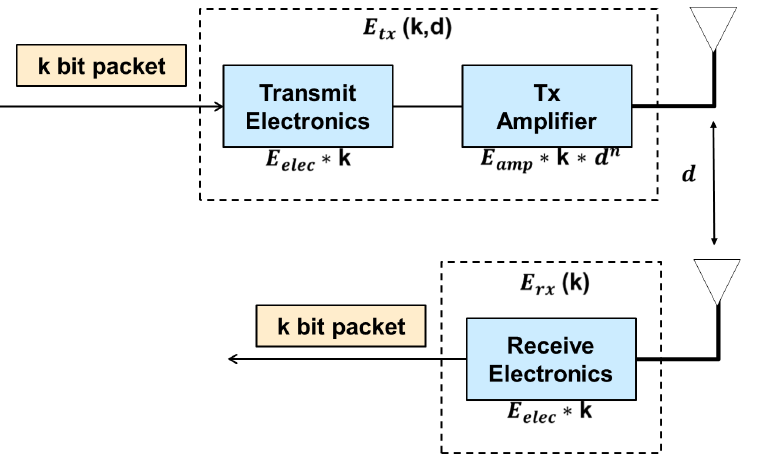
Figure 3. Energy propagation model of low-energy adaptive clustering hierarchy